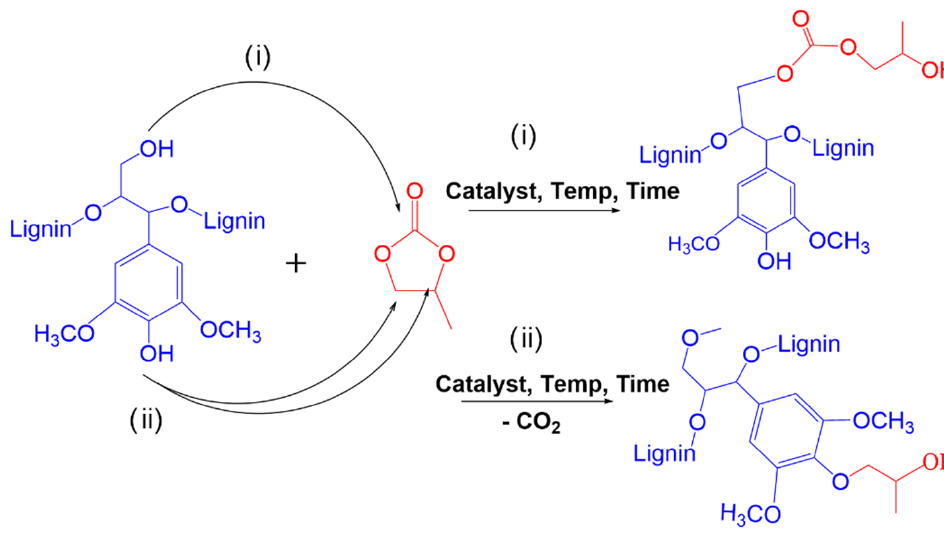
Figure 3. Main synthetic paths involved in lignin oxyalkylation with PC (i) PC can react with aliphatic OH, (ii) PC can react phenolic OH [17].